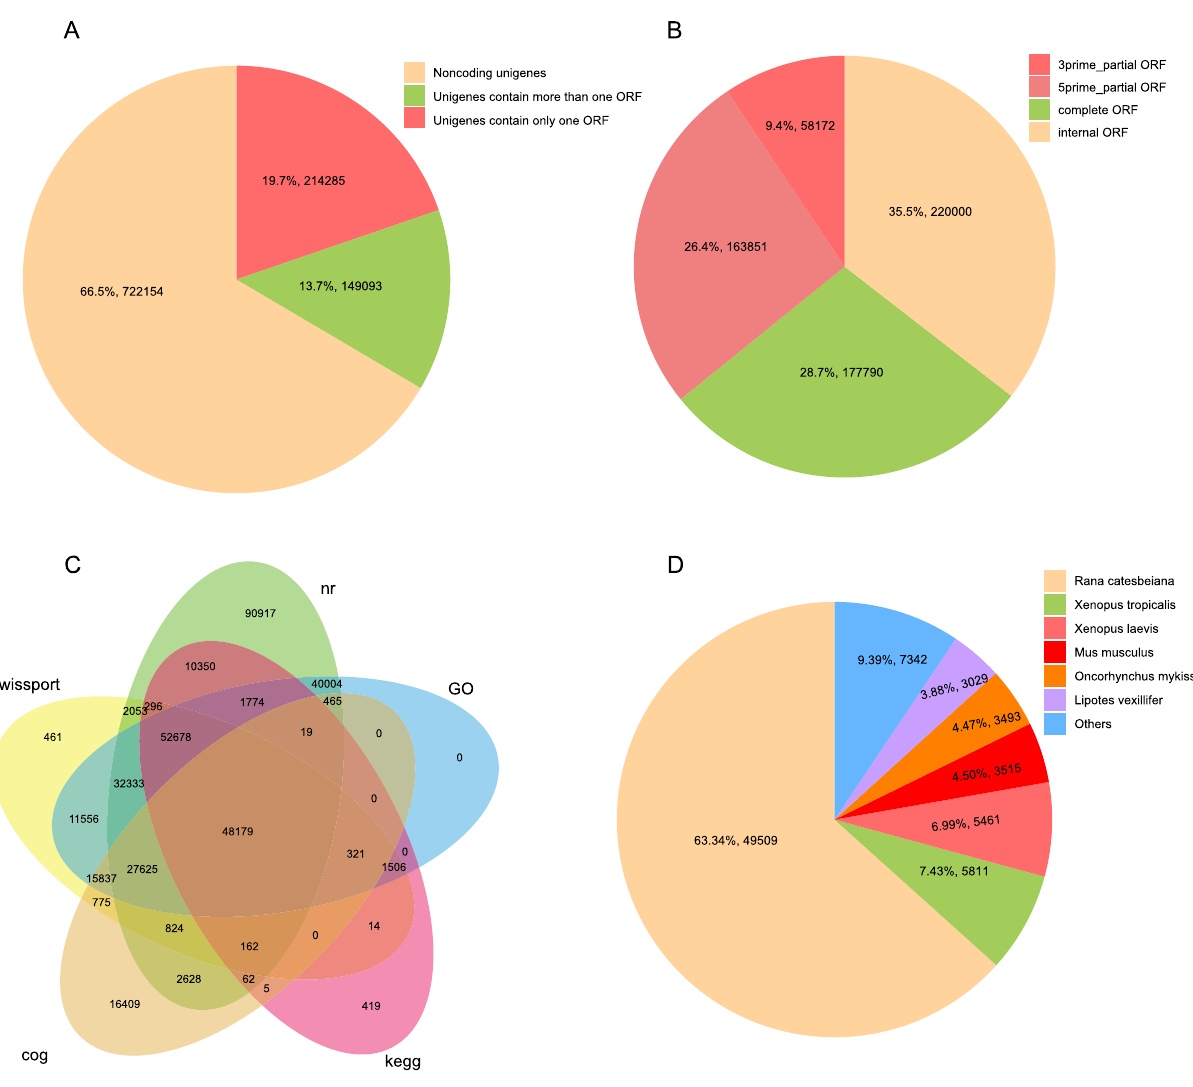
Figure 1. Coding gene prediction and annotation of unigenes. ( A ) Piechart showing the identification results of assembled unigenes coding ability by TransDecoder. ( B ) Piechart showing the classification of all identified open reading frames (ORFs). ( C ) Venn-diagram showing the overlap between results of unigenes aligned to NR, Swiss-Prot, KEGG, COGs and GO databases. ( D ) Species annotation results from unigenes aligned to NR